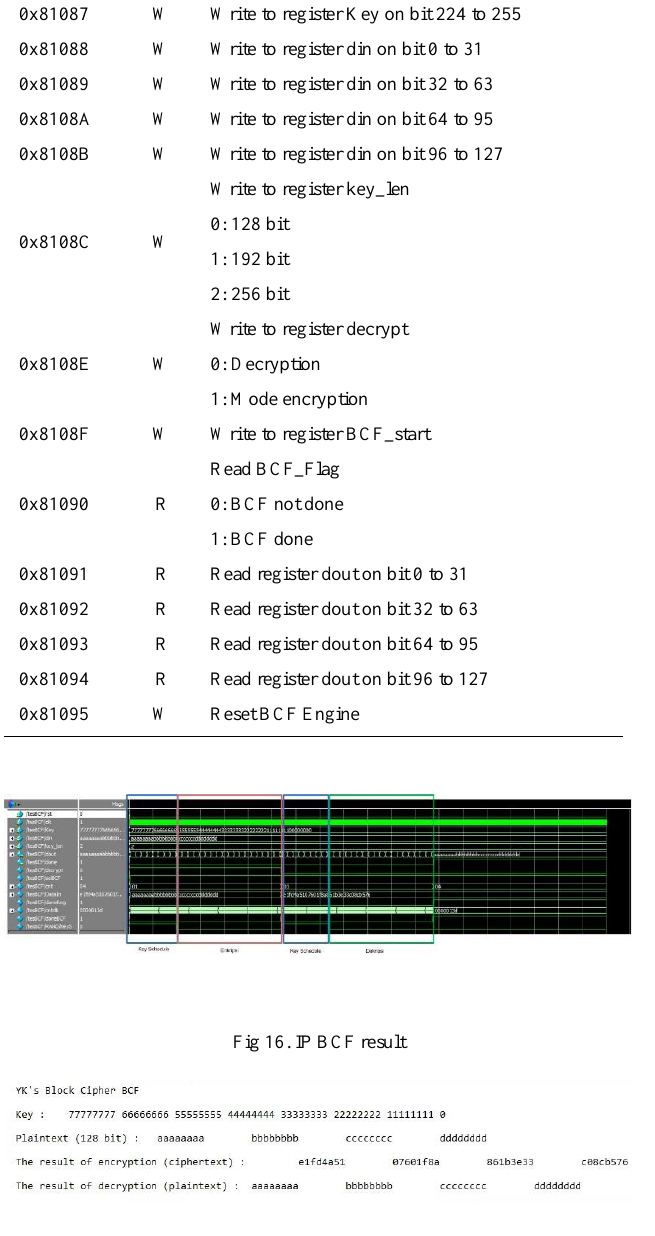
Fig 17. BCF engine computer result